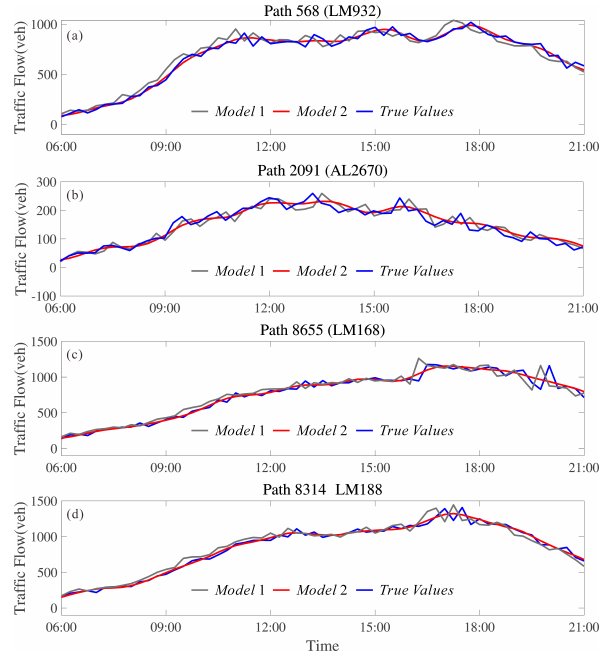
Figure3. Thisisafigure,Schemesfollowthesameformatting. Iftherearemultiplepanels,theyshould Figure 13. Tra ffi c flow forecasting results on Sunday of: ( a ) path 568(LM932); ( b ) path 2091(AL2670); belistedas: ( a )Descriptionofwhatiscontainedinthefirstpanel. ( b )Descriptionofwhatiscontained inthesecondpanel. Figuresshouldbeplacedinthemaintextneartothefirsttimetheyarecited. A ( c ) path 8655(LM168); ( d ) path 8314 (LM188). captiononasinglelineshouldbecentered. Table 3. Measures of the four assimilation models.